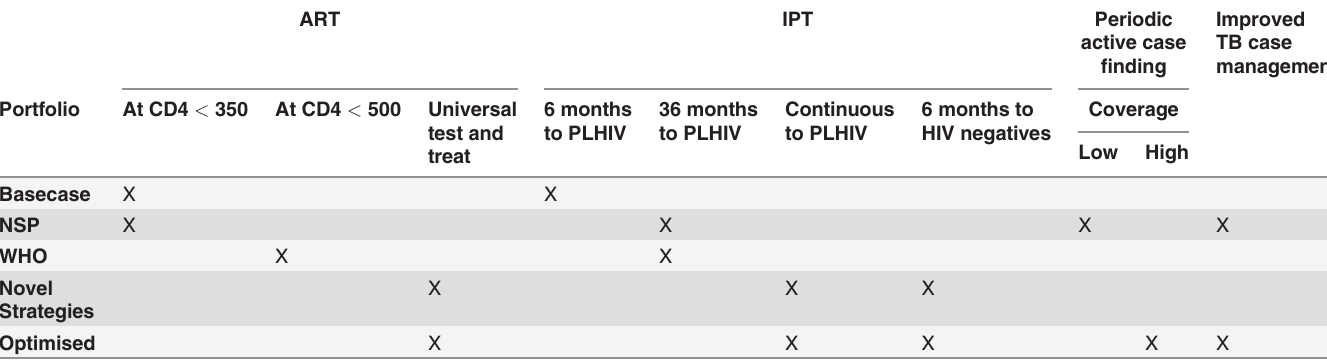
Table 1. Summary of the interventions included in each